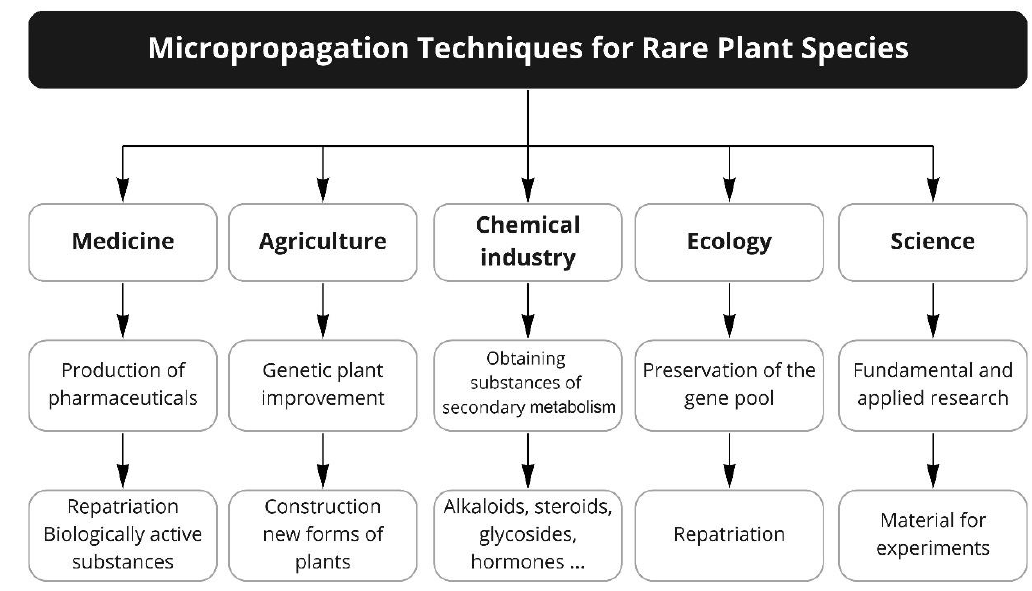
Figure 1. Application of micropropagation techniques for rare plant species.